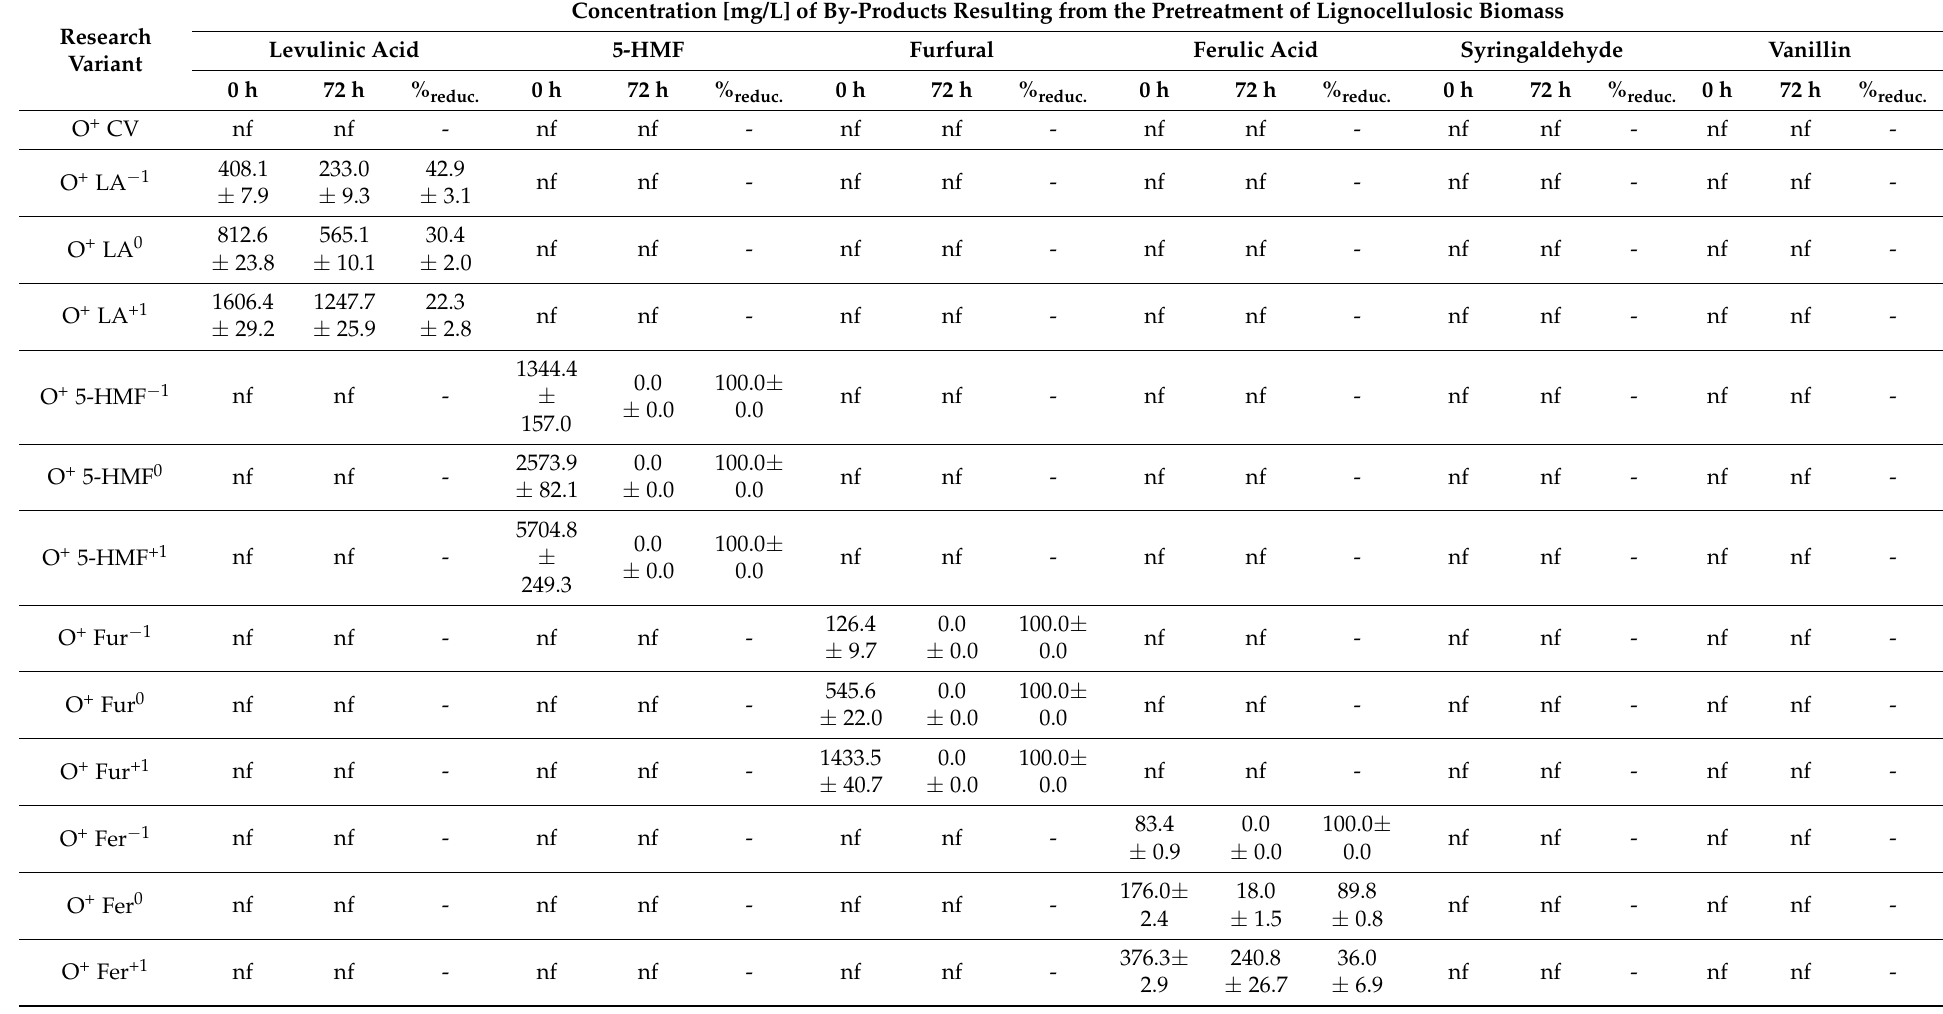
Table 1. Concentration of Lignocellulosic Biomass Pretreatment By-Products in Experimental Variants Before and After S. cerevisiae Yeast